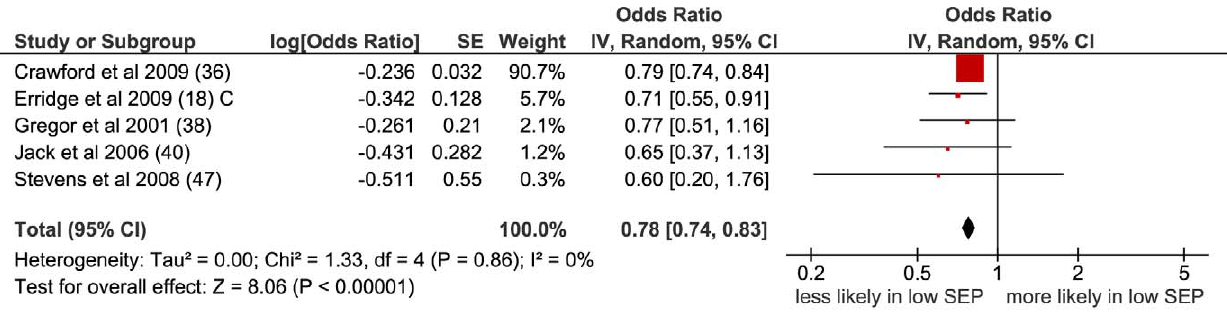
Figure 5. Meta-analysis of odds of receipt of unspecified treatment in low versus high SEP. CI, confidence interval; OR, odds ratio; SE, standard error; SEP, socioeconomic position.